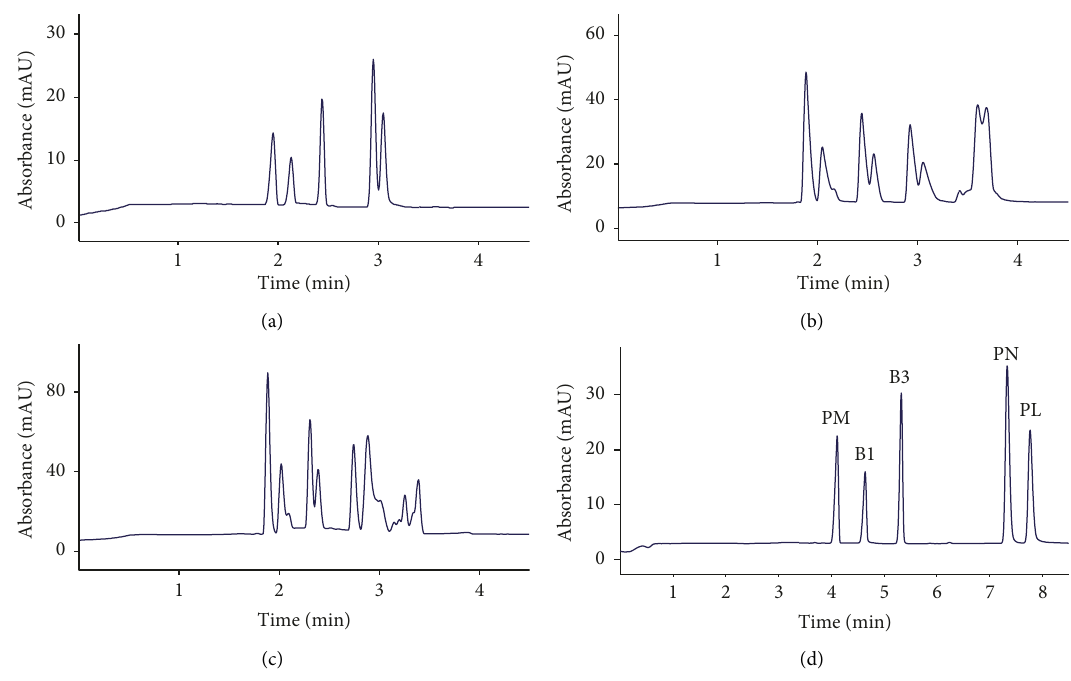
Figure 1: Electropherograms of a standard vitamin mixture (conc. 2.5–4.5mM) analysed with BGEs: (a) BGE A: 50mM phosphoric acid, 25mM Tris (current 52 µ A), (b) BGE B :50mM phosphoric acid, 50 mM glycine (current 52 µ A), or (c) BGE C :100mM phosphoric acid, 100mM glycine (current 84 µ A), at 20kV, or with (d) BGE D :100mM phosphoric acid, 55mM T-EthA (current 46 µ A) at 13kV. PM: pyridoxamine, B1: thiamine, B3: nicotinamide, PN: pyridoxine, and PL: